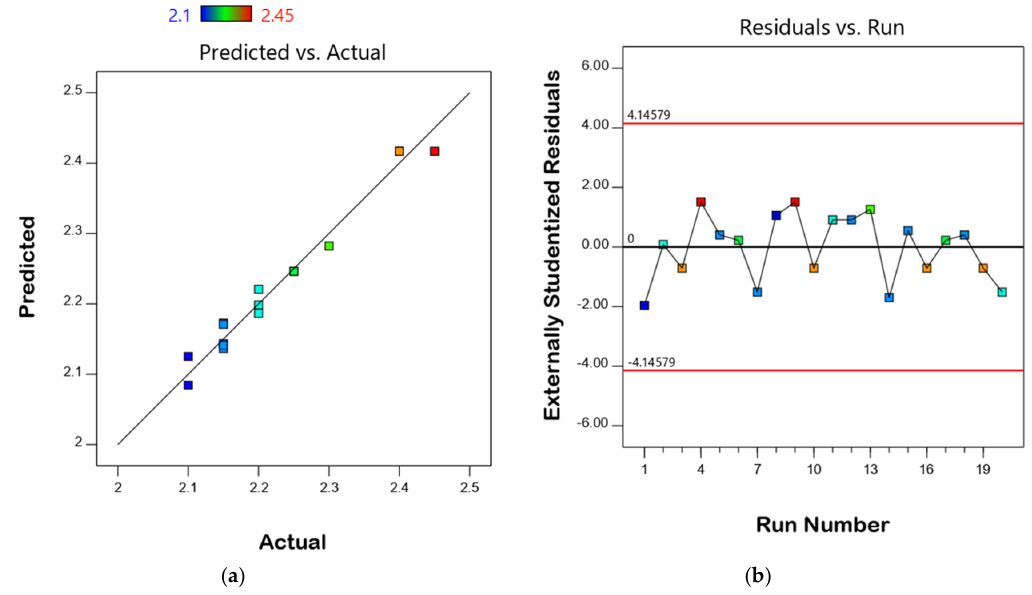
Figure 10. Plots of ( a ) actual data versus predicted data and ( b ) residuals calculated from the model. Plotting the response variable (oil yield) with respect to two variables yielded three surfaces as follows.